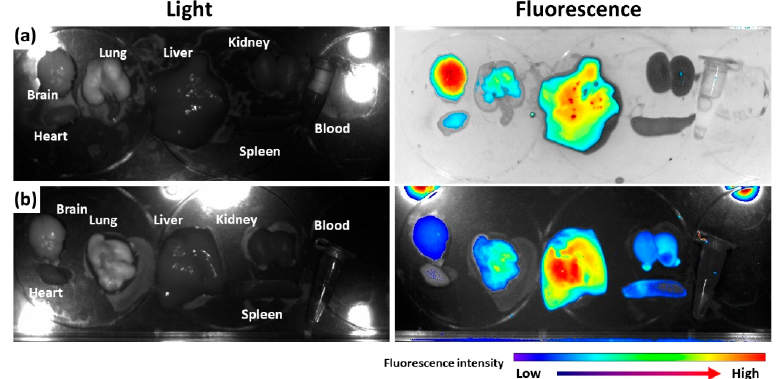
Figure 5. Biodistribution of bCDsuTHCe6 nanoparticles ( a ) and bCDsuCe6 nanoparticles ( b ). The synthesis schemes of bCDsuTHCe6 and bCDsuCe6 nanoparticles are illustrated in Figure S2. For fluorescence imaging of nanoparticles, nude BALb/C mice (male, 20 g, 5 weeks old) were used. bCDsuTHCe6 or bCDsuCe6 nanoparticles were intravenously administered via the tail vein of the mice. The injection dose was 10 mg Ce6/kg mouse. Injection solution was sterilized with a 0.8 µ m syringe filter. Injection volume was 100 µ L. After 24 h of injection, the mice were sacrificed and then each organ was observed with a Maestro TM 2 small animal imaging instrument.